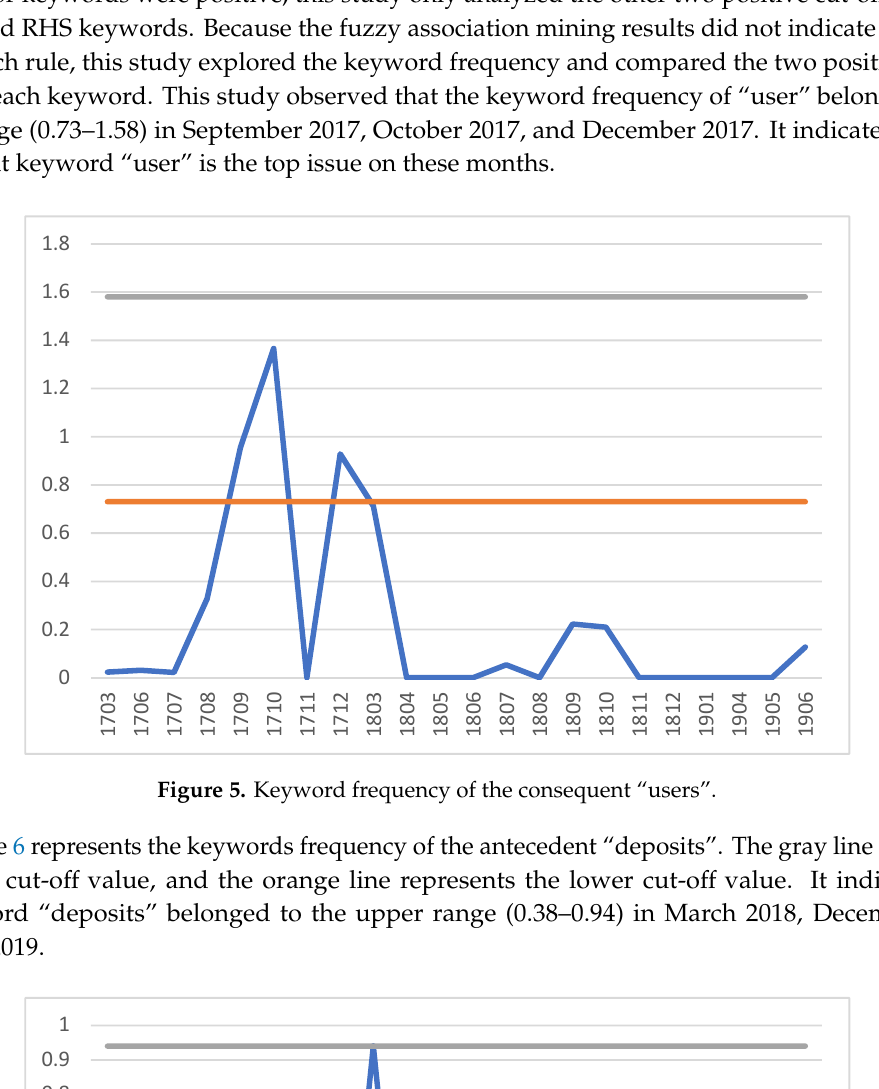
Figure 5 represents the keyword frequency data of the keyword “user” with the two cut-o ff values lines in Table 4. The gray line represents the upper cut-o ff value, and the orange line represents the